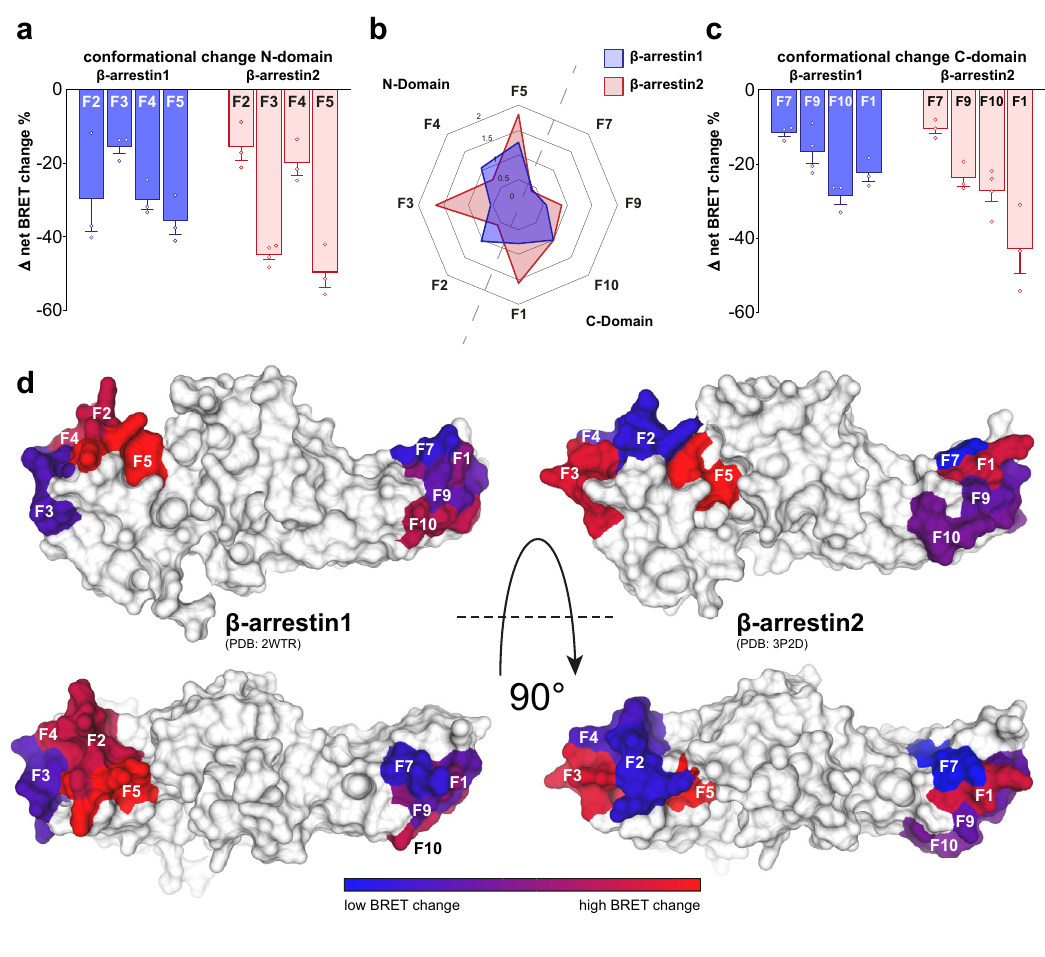
Fig. 3 | β -arrestin1 and 2 display different conformational change signatures upon coupling to the PTH1R. a Depiction of conformational changes induced by PTH1R activation for β -arrestin1 and 2 at 3 µ M PTH(1-34) for sensors located in the respective N-domains. The β -arrestin conformational change data were generated by transfection of HEK-WT cellswithanuntagged PTH1R-WT expression construct and one β -arrestin conformational change biosensor, FlAsH-labelling and stimula- tionwith3 µ MPTH(1-34).Resultsareshownas Δ netBRETchangeinpercent,mean of at least three independent repetitions ( β -arrestin2-F3 n =4, all other sensors n =3)±SEM. b Radar chart representation of the data from a and c , normalised to the respective F10biosensor valuesineach dataset, asthisparticularsensor shows